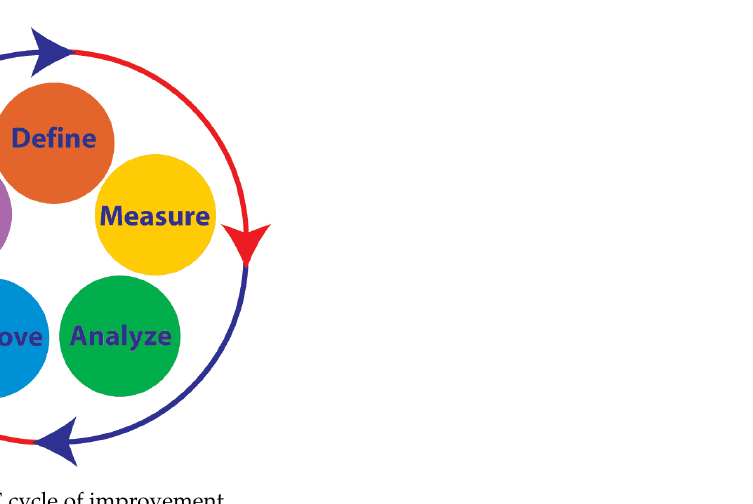
6 of 13 Table 1. Global Performance Index—GPI values and Performance range. GPI